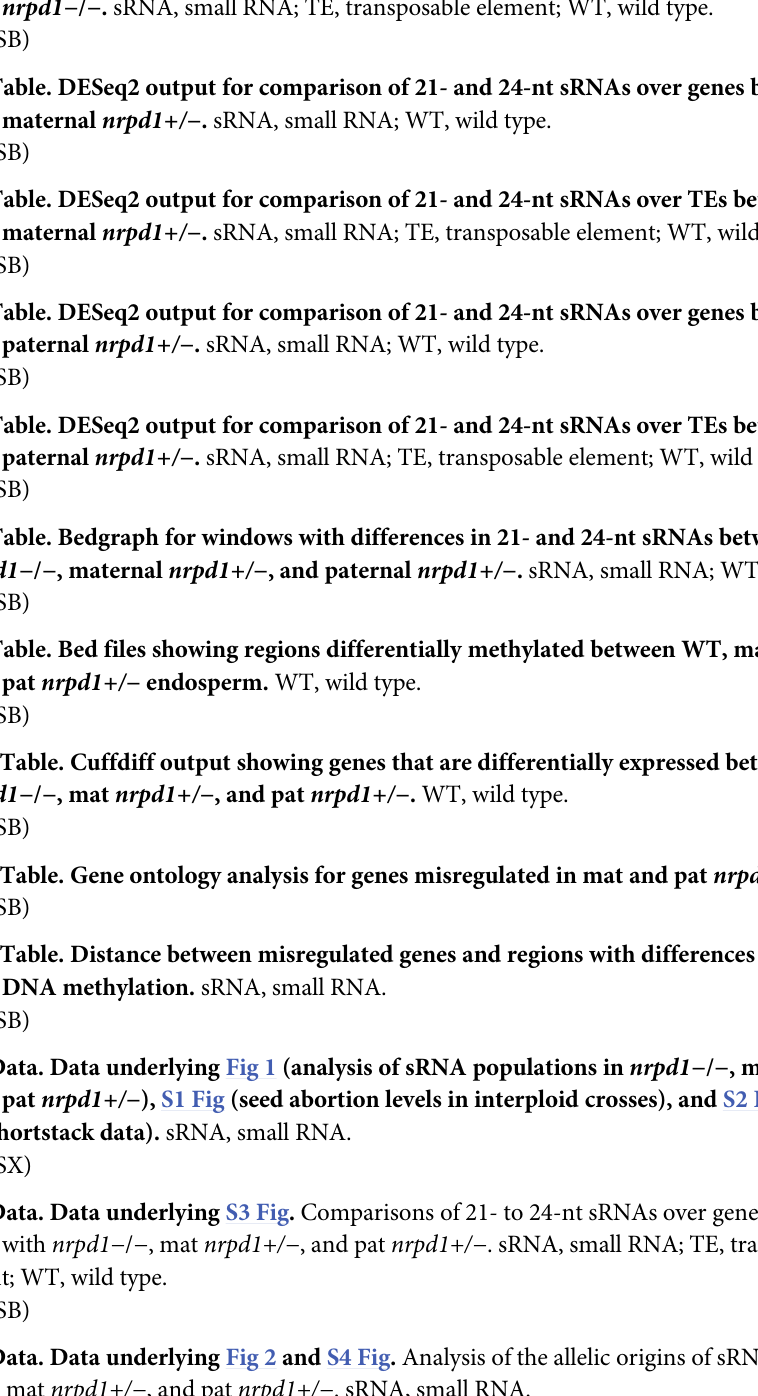
S3 Table. DESeq2 output for comparison of 21- and 24-nt sRNAs over TEs between WT